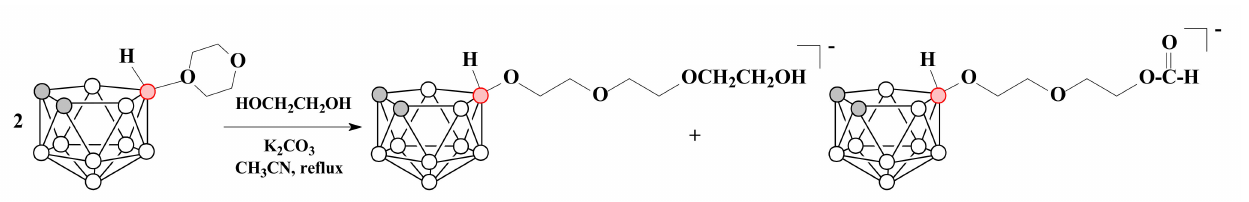
[10-HO(CH 2 CH 2 O) 3 -7,8-C 2 B 9 H 11 ] − along with a certain amount of carboranyl diethylene glycol formate [10-HC(O)O(CH 2 CH 2 O) 2 -7,8-C 2 B 9 H 11 ] − [78] (Scheme 9).